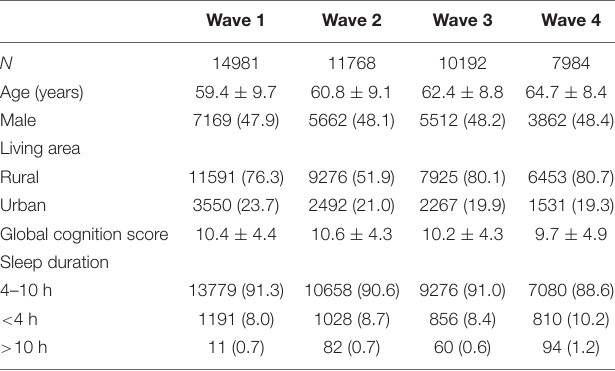
TABLE 1 | Characteristics of the study population at each